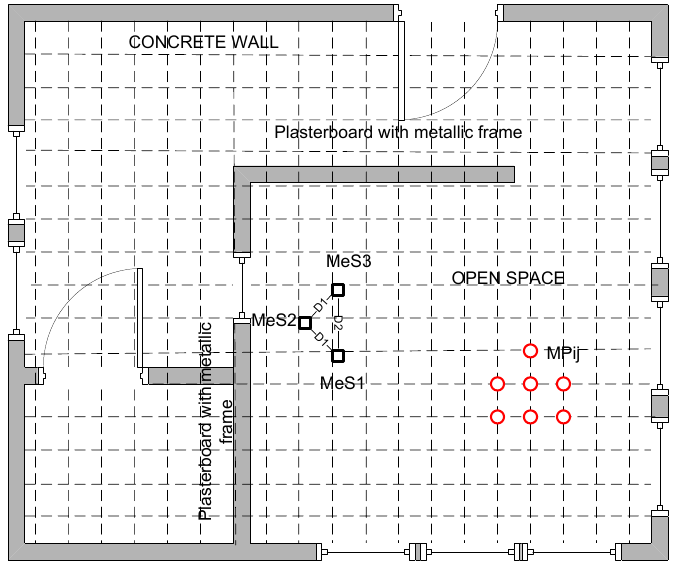
Figure 4. Laboratory setup for measuring variation of RSSI according to distance from MeSs and over time.